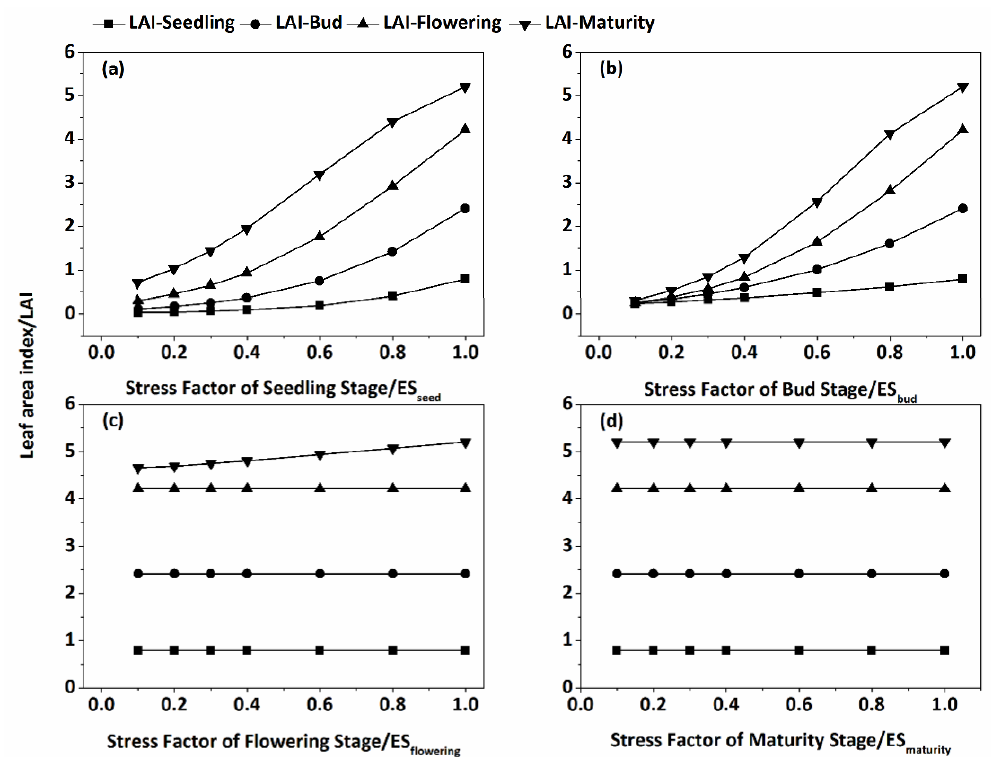
Figure 9. Change in leaf area index (LAI) with stress factors in the seedling ( a ), bud ( b ), flowering ( c ), and maturity ( d ) stages in 2012.